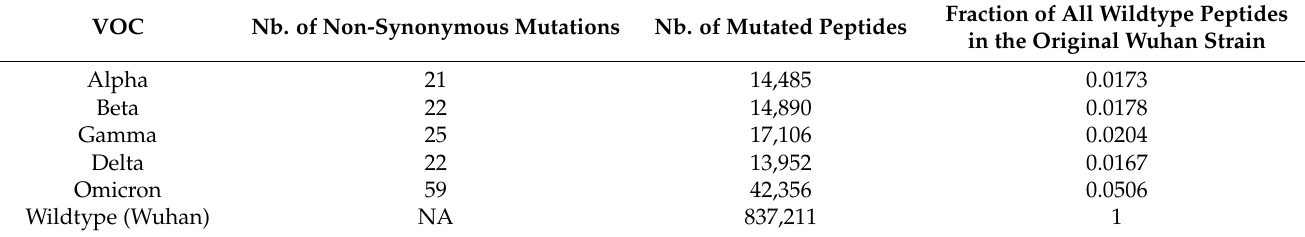
Table 2. Number of peptides with AP score >0.5 in either the mutant or the corresponding wildtype for each of the VOCs and the fraction they represent out of the Wuhan Wildtype. “Wuhan Wildtype” is the number of peptides with antigen presentation score >0.5 in the complete original Wuhan